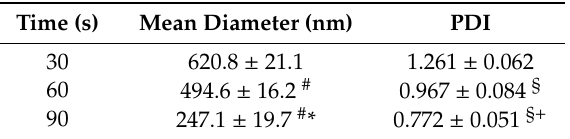
Table 4. Influence of sonication time on the particle size and polydispersity index (PDI) of the formulation containing Gelucire 44 / 14